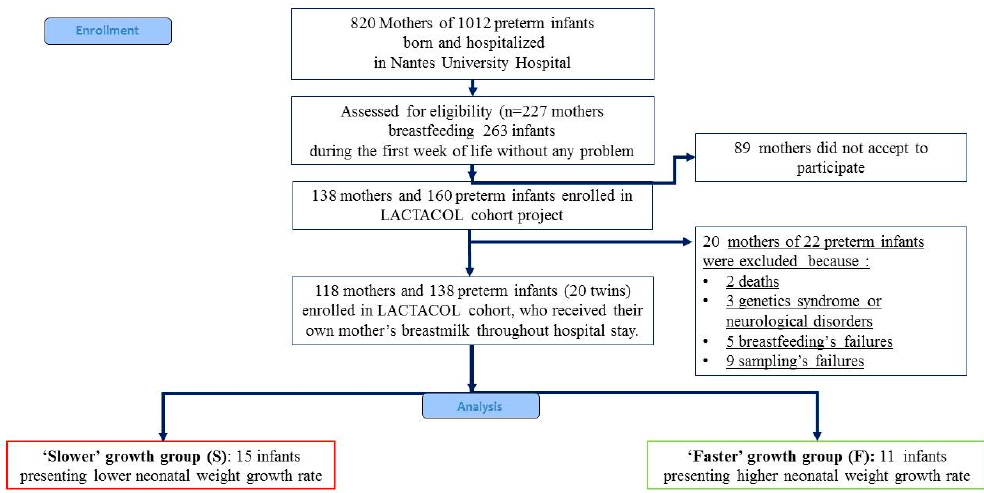
Figure 1. Flowchart of infants enrolled in the ancillary study of the mono-centric prospective population-based LACTACOL. (ClinicalTrials.gov Identifier: NCT01493063, acronyme for “Impact of Breast Milk on the Neurodevelopment of Preterm Newborns"). Table 1. Maternal and preterm infants’ characteristics.